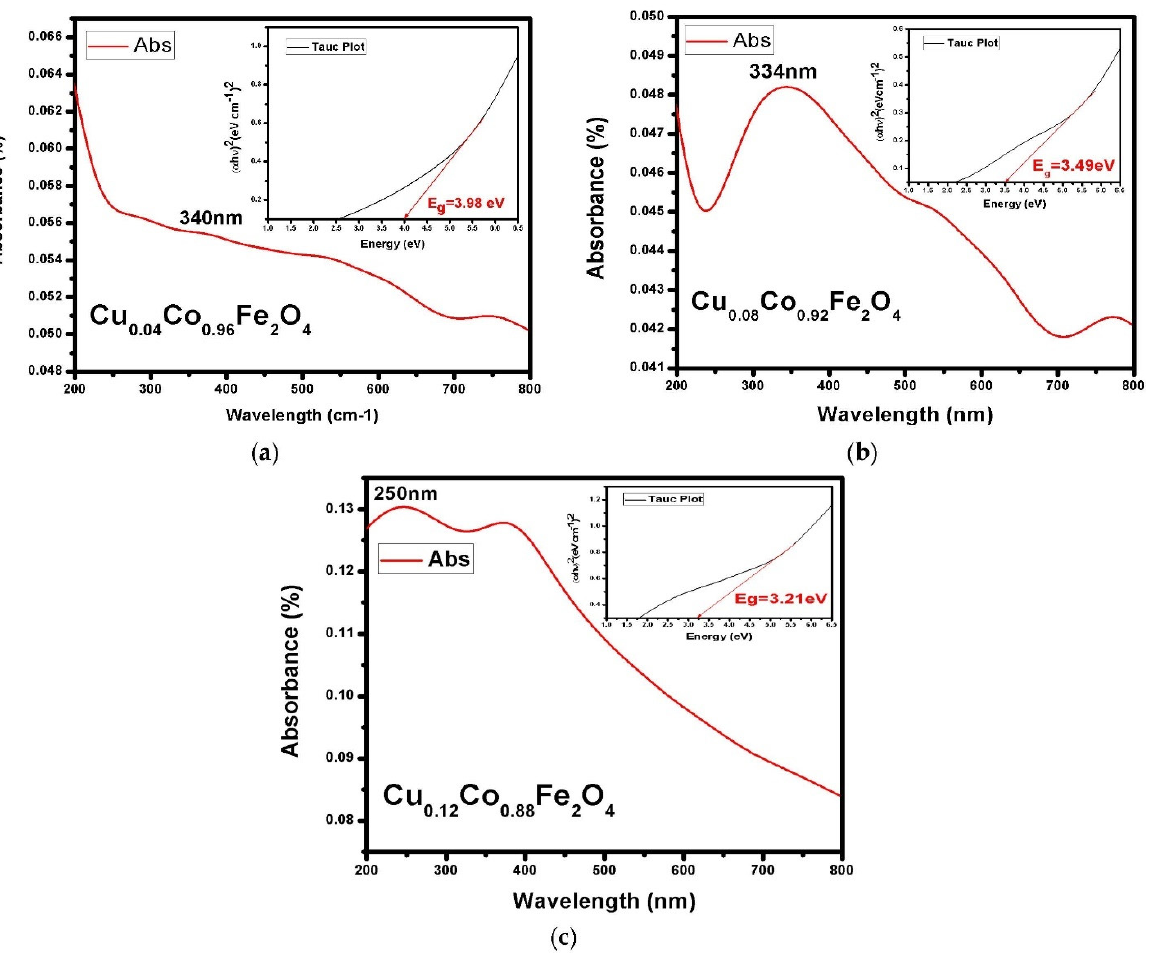
Figure 4. UV − VIS absorption patterns of Cu 2+ of CFO NPs doped with different concentrations of Cu 2+ ions. ( a ) Cu 0.04 Co 0.96 Fe 2 O 4 , ( b ) Cu 0.08 Co 0.92 Fe 2 O 4 , ( c ) Cu 0.12 Co 0.88 Fe 2 O 4 .